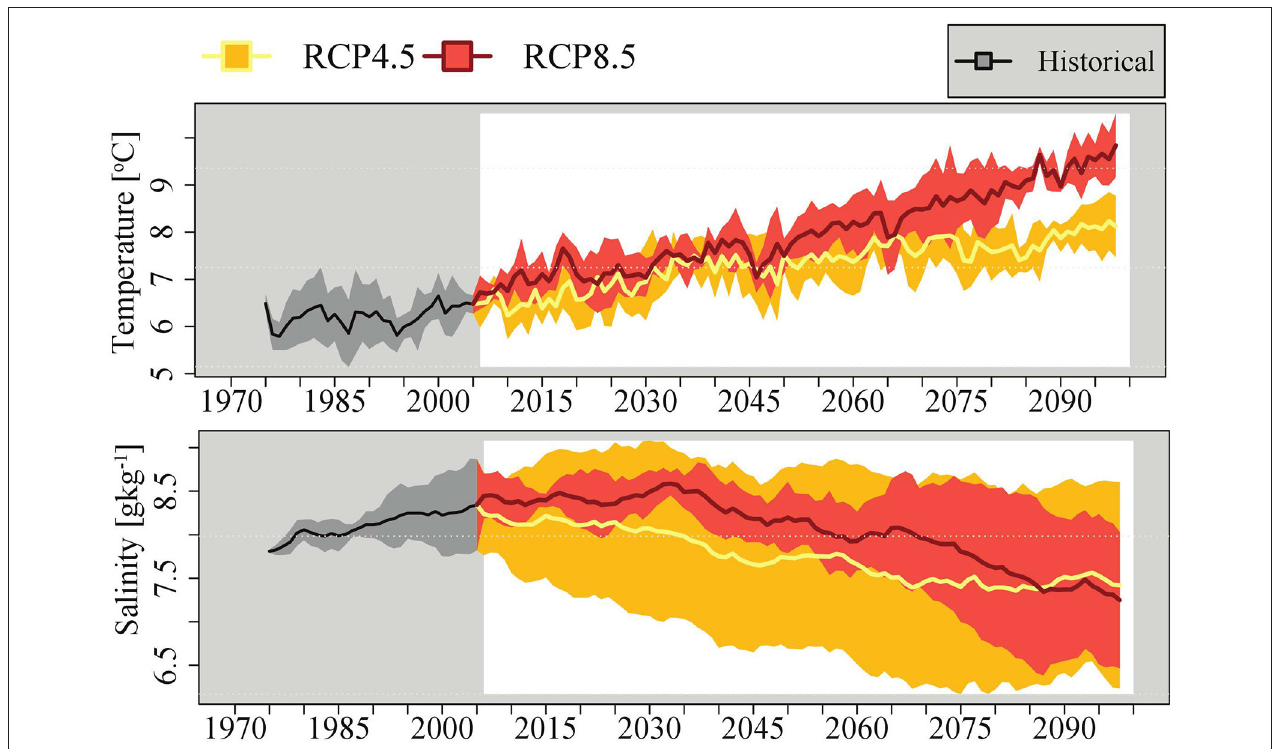
FIGURE 6 | Ensemble mean volume averaged temperature (in ◦ C ) and salinity (in g kg − 1 ) as a function of time for 1975–2098 in the two climate scenarios, RCP 4.5 (orange) and RCP 8.5 (red). The colored shaded areas denote the standard deviations among the ensemble members.